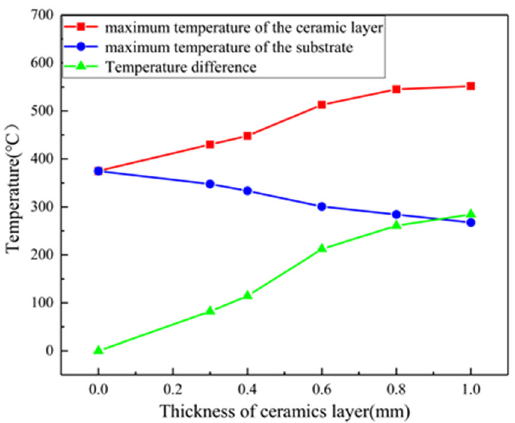
Figure 14. Effects of ceramic-layer thickness on TBC piston temperature.